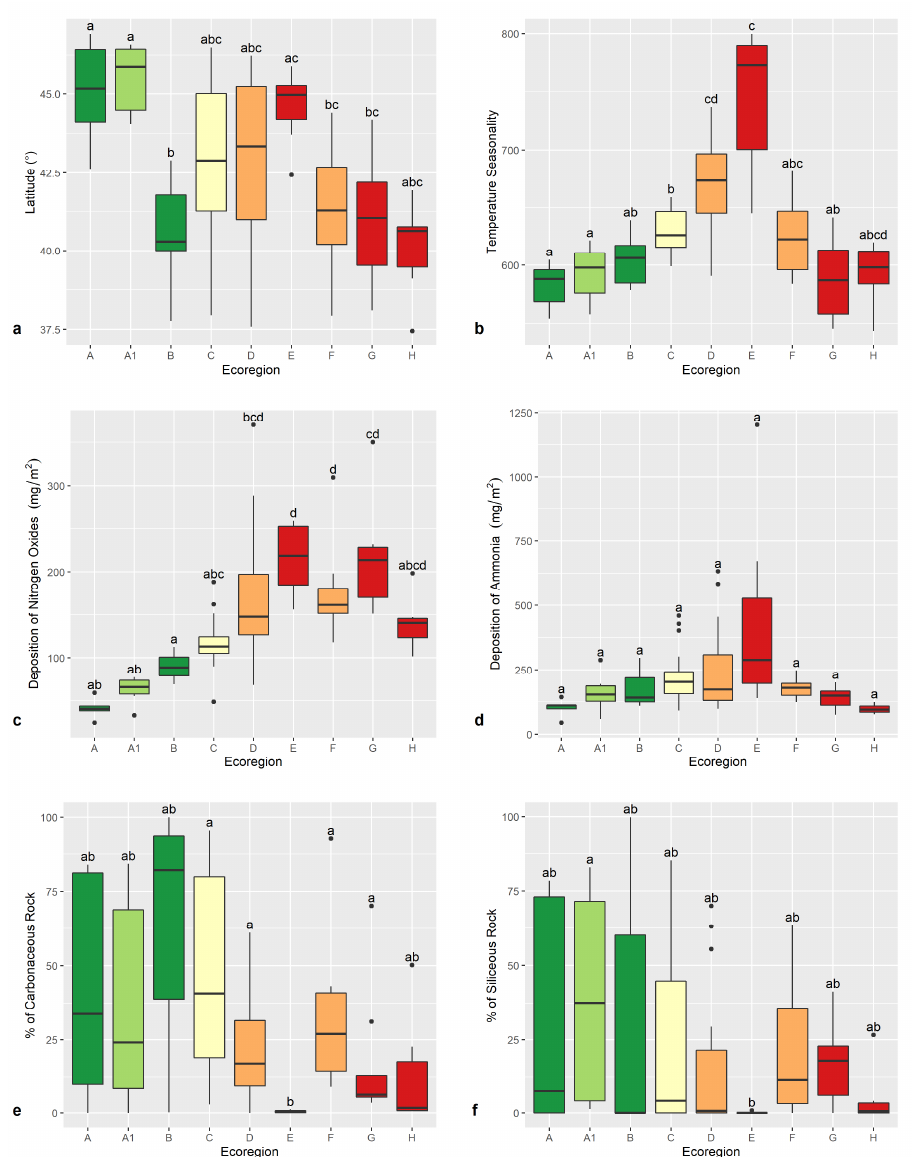
Figure 5. Box-plot graphs depicting average latitude ( a ), average temperature seasonality ( b ), average deposition of nitrogen oxides (NO X ) (mg/m 2 ) ( c ), average deposition of ammonia (NH 4 , NH 4+ ) (mg/m 2 ) ( d ), percentage of carbonatic substrata ( e ), and percentage of siliceous substrata ( f ) for the OGUs of the 9 ecoregions: Alpine (A), Subalpine (A1), Oromediterranean (B), Montane (C), Dry Submediterranean (D), Padanian (E), Humid Submediterranean (F), Humid Mediterranean (G), Dry Mediterranean (H). Significant differences are labeled by different letters (Wilcoxon test). Box colors show ecoregions with the same altitudinal range. Color codes are green (high-altitude ecoregions), yellow (Montane ecoregion), orange (Submediterranean ecoregions), and red (Mediterranean ecoregions).